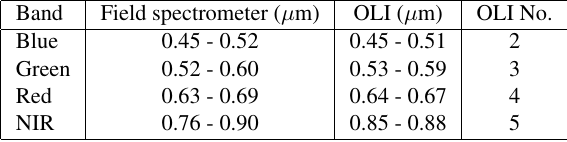
Table 1: Comparison of field spectrometer and Operational Land Imager (OLI)